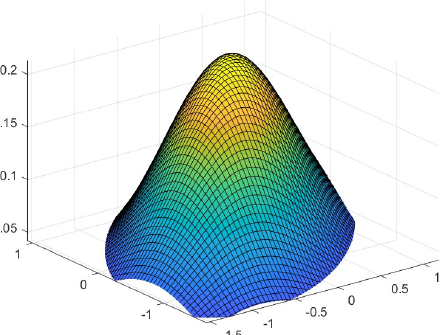
Figure 3. Basic principle in calculus method. When the area of curved surface is small enough, it can be approximated as a bevel surface.